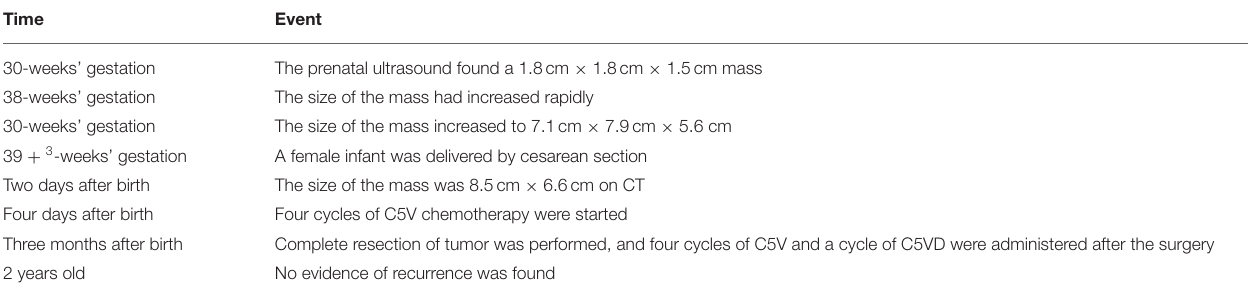
TABLE 1 | Timeline of the episode of